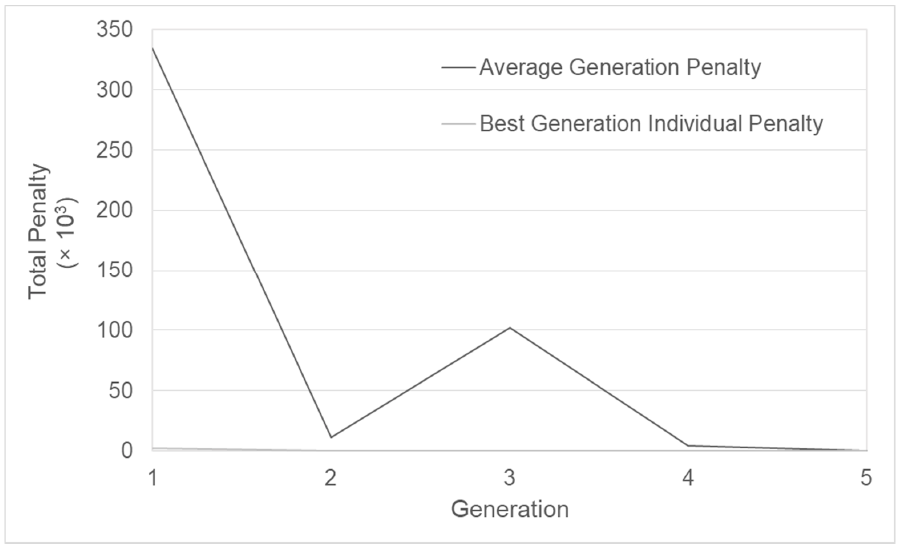
Figure 6. Evolution of the mean and average penalty per generation for a run of 5 iterations, using a penalty function assigning a significant penalty to very large objects (>5000 px) and a size-dependent penalty to very small objects.